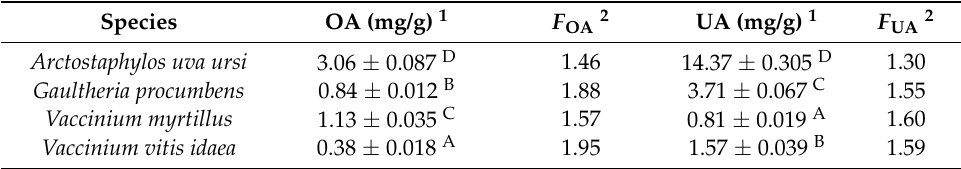
Table 8. Results of OA and UA determination obtained with alternative extraction procedure and correction